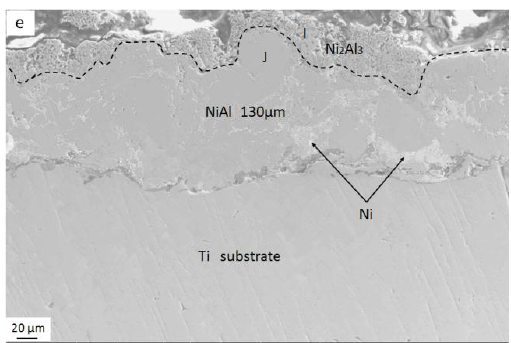
Figure 3. ( a ) Cross-sectional SEM image of the Al/Ni coating without heating; ( b – e ) cross-sectional SEM images of Al/Ni coating after testing for 2, 5, 10, and 20 h at 973 K. Table 3. Chemical composition (at %) of different points, as marked in Figure 3b–e.